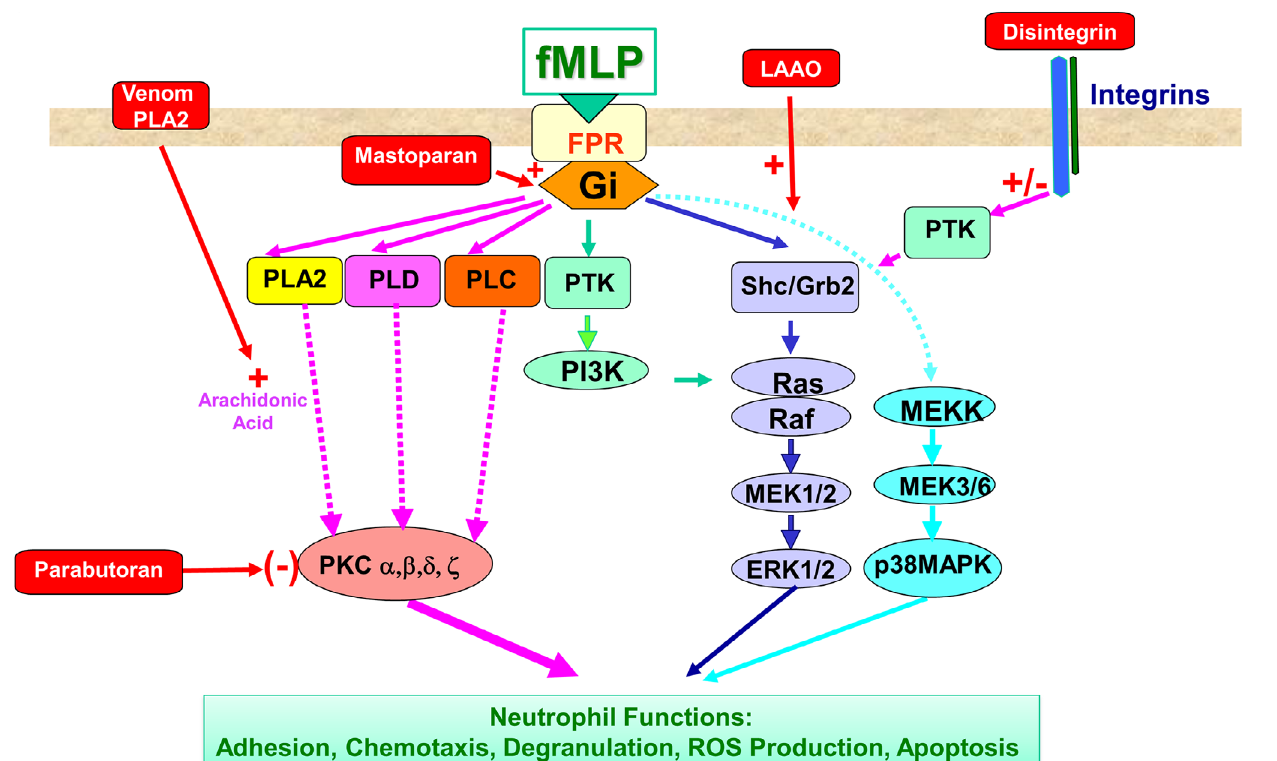
Figure 4. Molecular events underlying neutrophil activation and the effects of venom components. The fMLP peptide binds to its receptor called FPR (formyl peptide receptor), which activates heterotrimeric Gi proteins (proteins binding guanosine triphosphate, GTP) and tyrosine kinases. The G proteins then activate enzymes such as phospholipase C (PLC), phospholipase A2 (PLA2), phospholipase D (PLD), leading to the release of intracellular messengers, i.e., PLC catalyzes the formation of diacylglycerol (DAG) and inositol-triphosphate (IP3) from phosphatidylinositol 4,5-biphosphate (PIP2). IP3 is involved in the release of calcium from intracellular pools, while DAG activates protein kinase C (PKC). Activation of PLD results in phosphatidic acid production from phosphatidylcholine. Activation of PLA2 leads to the cleavage of membrane phospholipids to produce arachidonic acid, which can then be used as a substrate for leukotrienes and prostaglandins synthesis. FMLP induces activation of protein tyrosine kinases (PTK), which are upstream of the MAPKinase pathways (ERK1/2 and p38MAPKinase). All these kinases control neutrophil functions such as chemotaxis, degranulation, NADPH oxidase activation and apoptosis. The effect of venom components (PLA2, LAAO, disintegrin, mastoparan and parabutoparan) is shown in